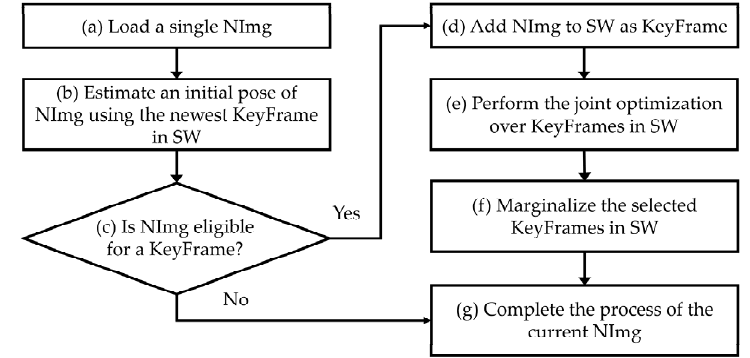
Figure 2. Flow chart of the direct sparse odometry (DSO) algorithm.